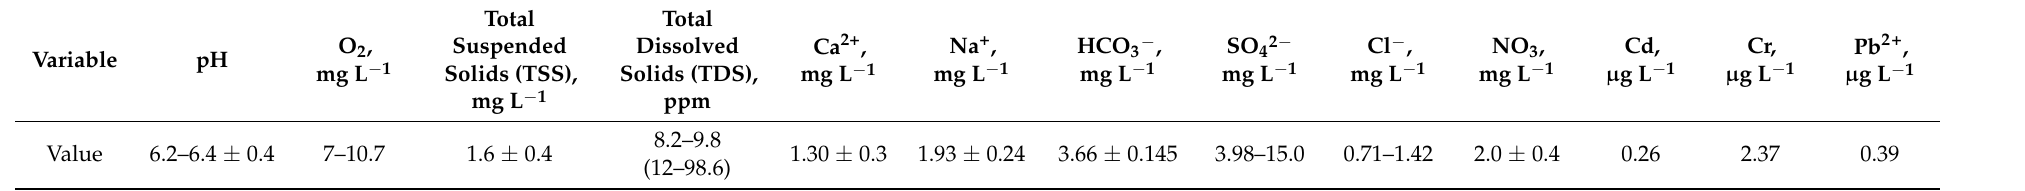
Table 1. Hydrochemical characteristics of the Nesamovyte Lake 1